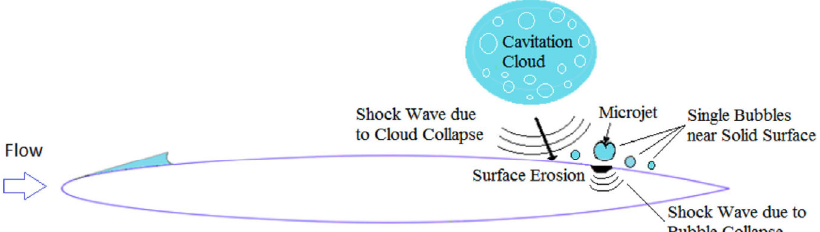
Fig. 28 An image of cavitation erosion near the trailing edge of a hydrofoil due to cloud cavitation dynamics [276]. Reproduced with permission from Ref. [276], © Elsevier B.V.,